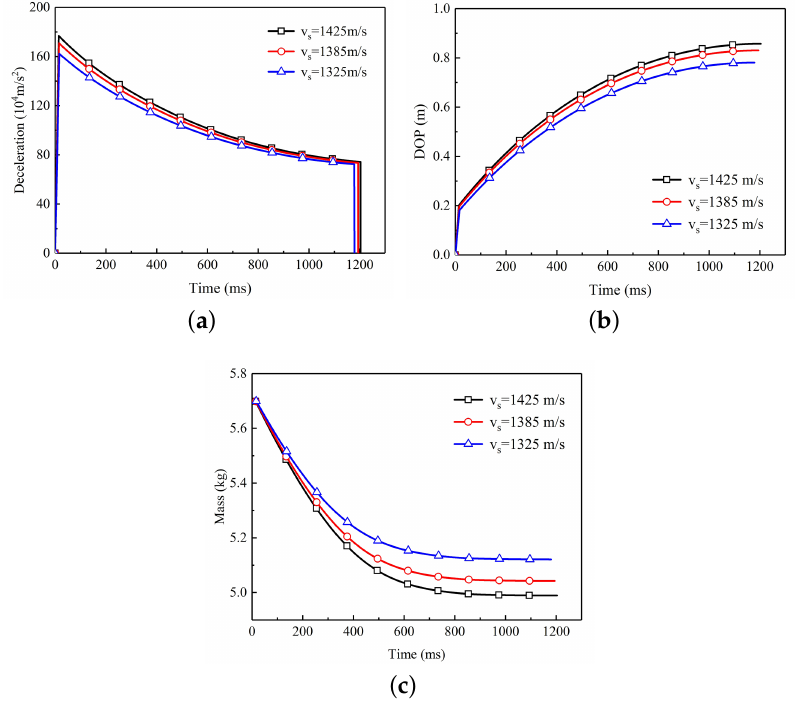
Figure 7. The variation of various parameters of the projectile versus time. ( a ) Relationship between deceleration and time. With the increase of penetration time, the deceleration decreases gradually. ( b ) Relationship between depth of penetration and time. With the increase of penetration time, the depth of penetration increases gradually. ( c ) Relationship between residual mass and time. With the increase of penetration time, the residual mass of projectiles decrease gradually and finally remains constant at the final